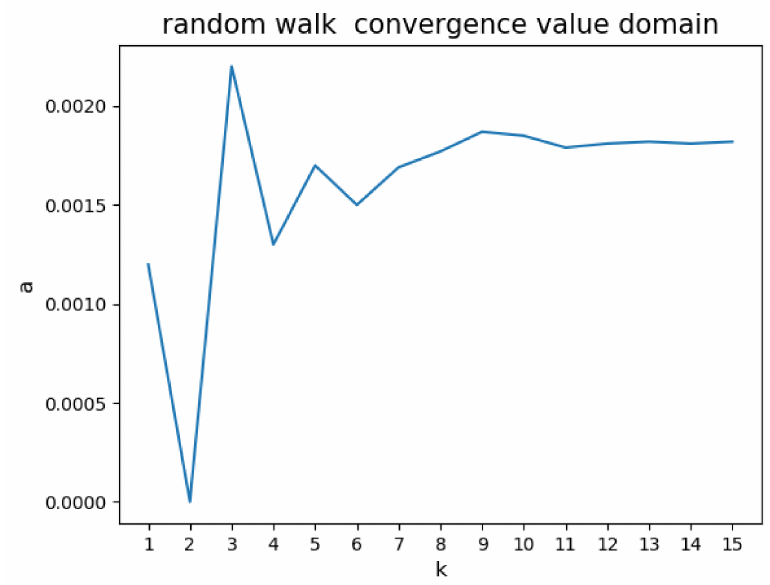
Figure 5. Random walk convergence